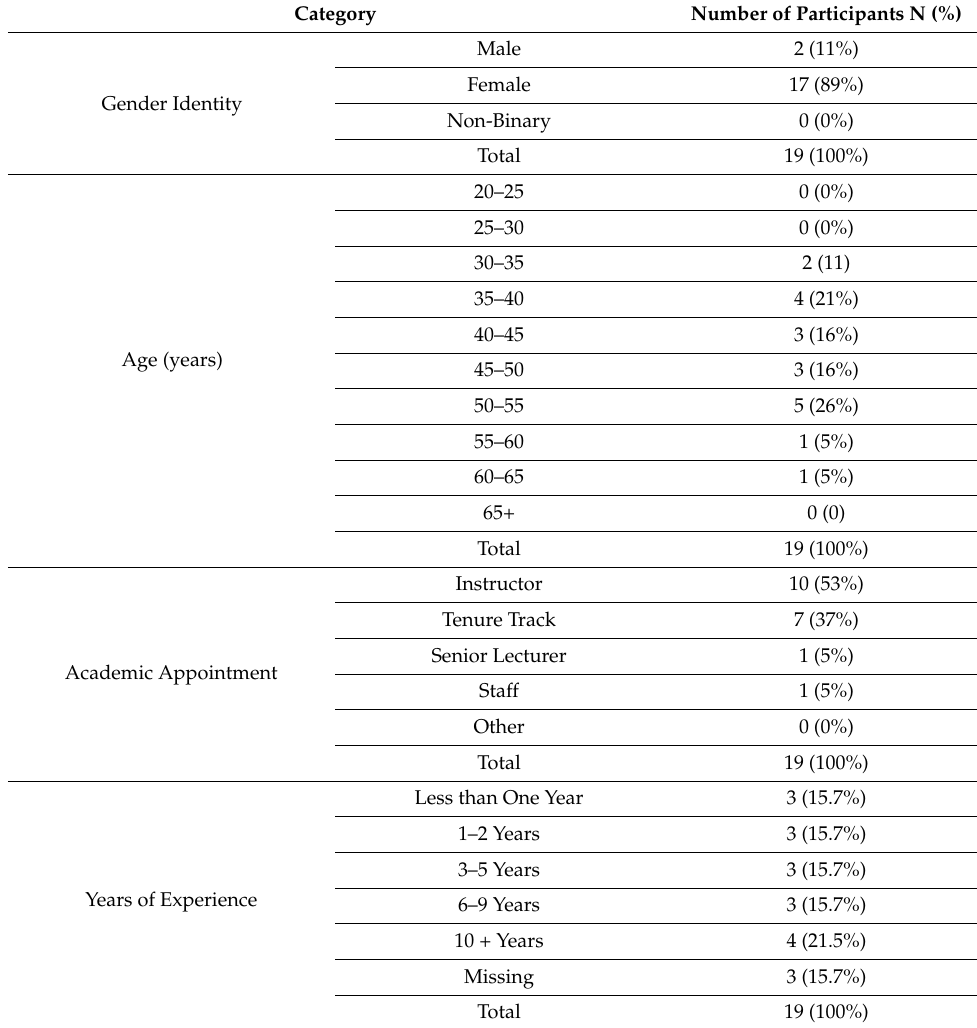
Table 1. Participant